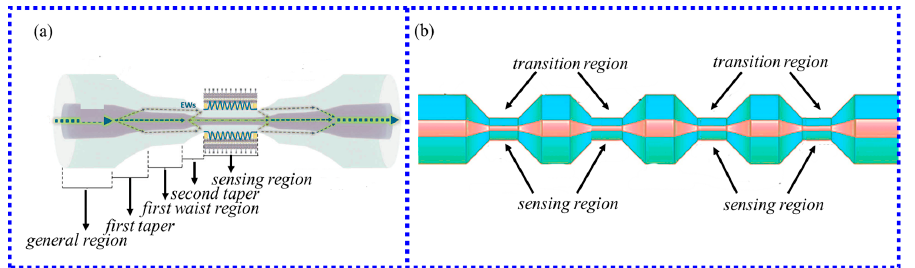
Figure 9. ( a ) Schematic diagram of taper-in-taper fiber structure [74]; ( b ) Schematic diagram of four periodic tapered fibers [75]. Copyright 2023,